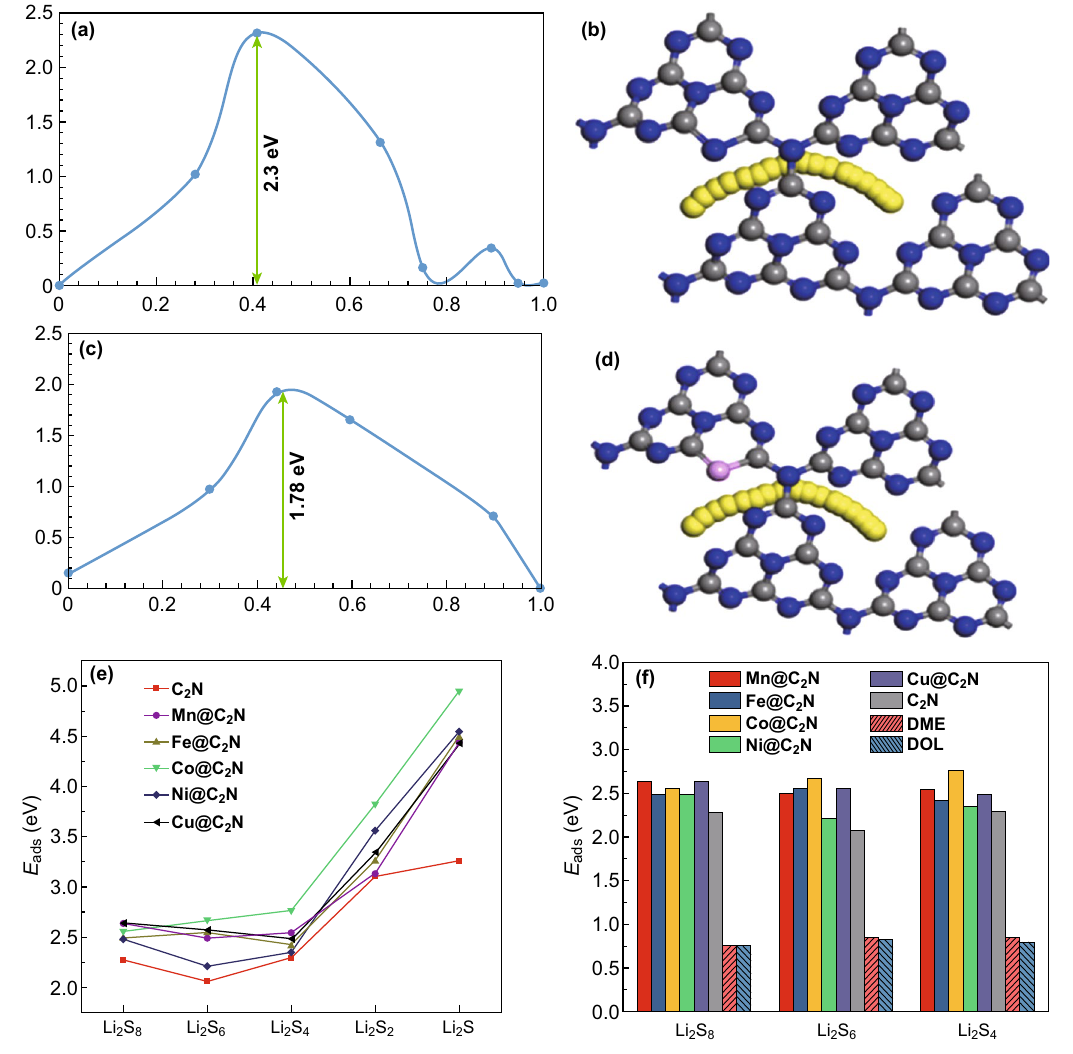
Fig. 8 a Energy barrier for Na diffusion through g-C 3 N 4 , b corresponding Na diffusion path. c Energy barriers for Na diffusion through P-g- C 3 N 4 , d corresponding Na diffusion path. Reproduced with permission from Ref. [32]. e Adsorption energies of LiPSs on transition metal embedded C 2 N monolayers. f Adsorption energies of long-chain LiPSs with transition metal embedded C 2 N, 1,2-dimethoxyethane (DME) and 1,3-dioxolane (DOL). Reproduced with permission from Ref. [28]. Copyright permissions from Springer Nature and Elsevier. (Color